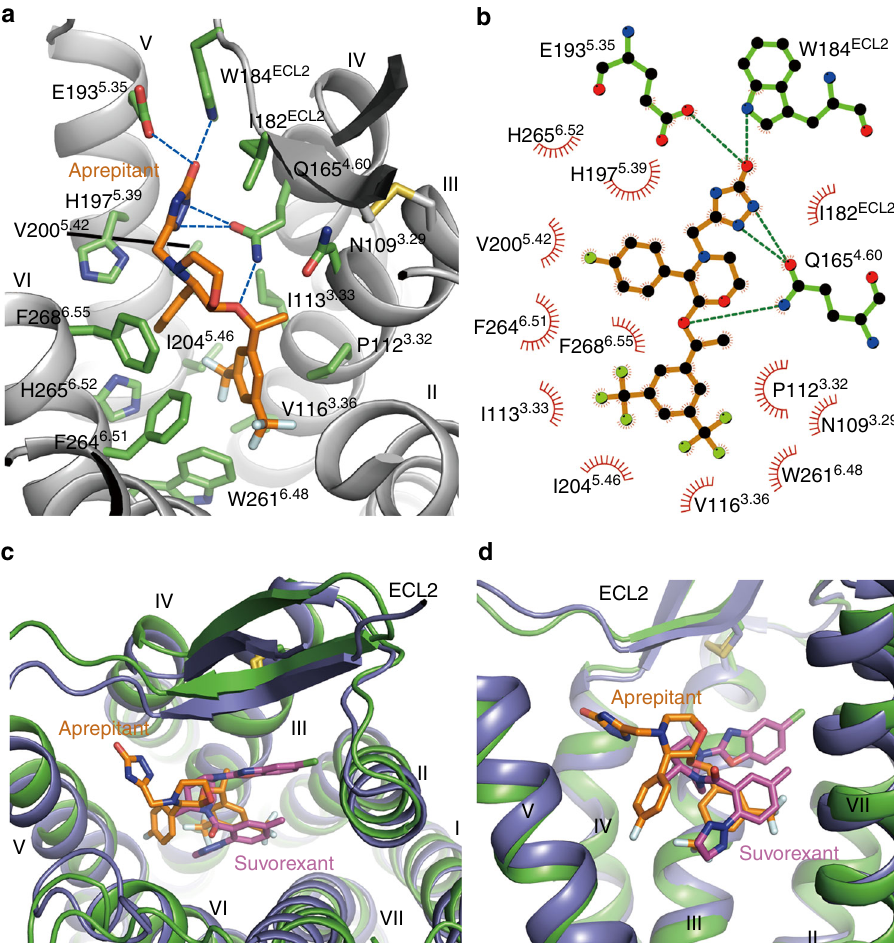
Fig. 2 The NK1R binding pocket for aprepitant. a Key residues of NK1R for aprepitant binding. The receptor is shown as gray cartoon. Aprepitant (orange carbons) and receptor residues (green carbons) involved in ligand binding are shown as sticks. Other elements are colored as follows: oxygen, red; nitrogen, dark blue; fl uorine, cyan. b Schematic representation of interactions between NK1R and aprepitant analyzed using the LigPlot + program 42 . Polar interactions are shown as dashed lines. c , d Comparison of ligand-binding sites between NK1R (green) and OX 2 R (PDB accession code: 4S0V; purple). The ligands aprepitant and suvorexant are shown as orange and magenta sticks, respectively. c Extracellular view. d Side